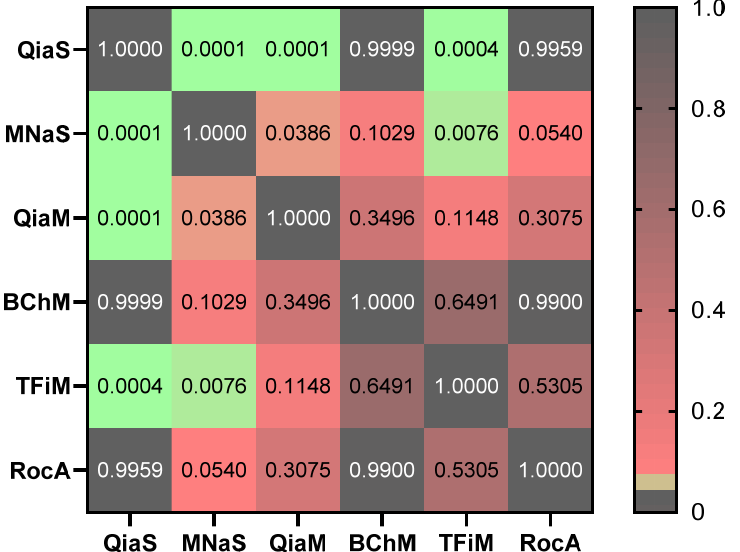
Figure 2. A heat map representation of the post-hoc multiple comparison of cfDNA recovery isolated using different extraction kits and measured with the Qubit HS DNA assay. Significant differences ( p < 0.05) are shown in green to orange.